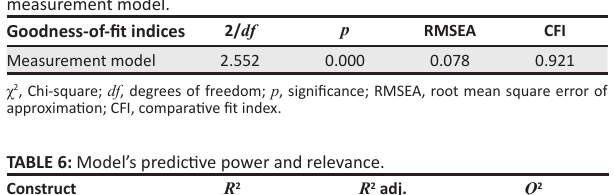
TABLE 5: Goodness-of-fit statistics for confirmatory factor analysis of the measurement model. Goodness-of-fit indices